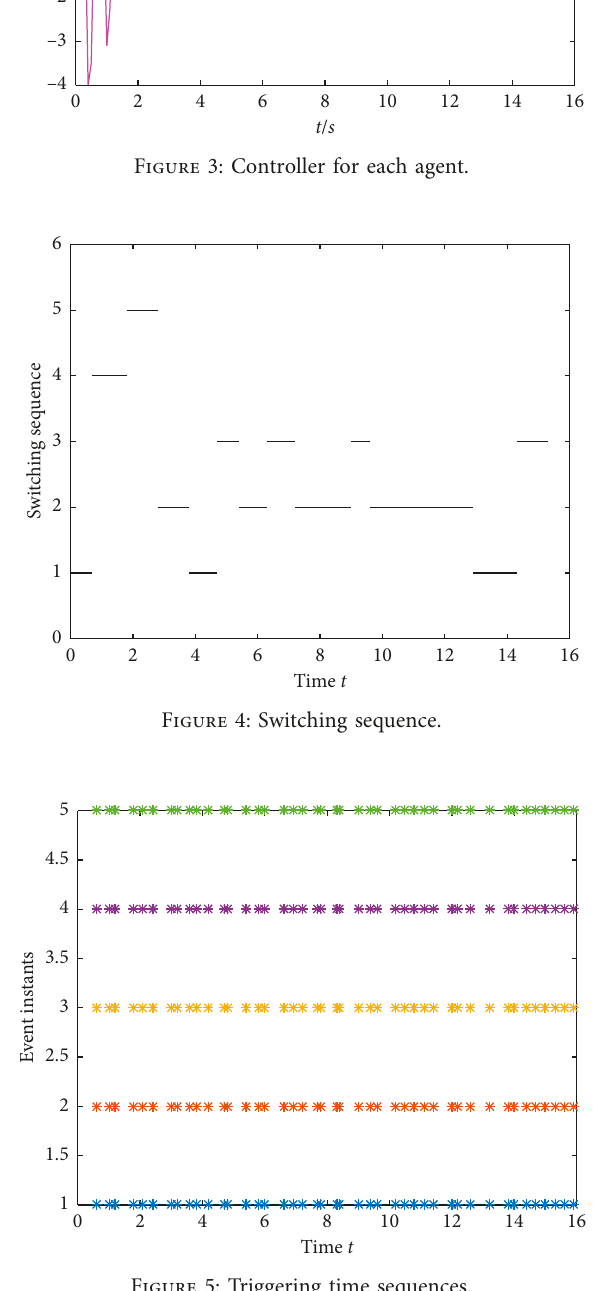
Figure 5: Triggering time sequences.